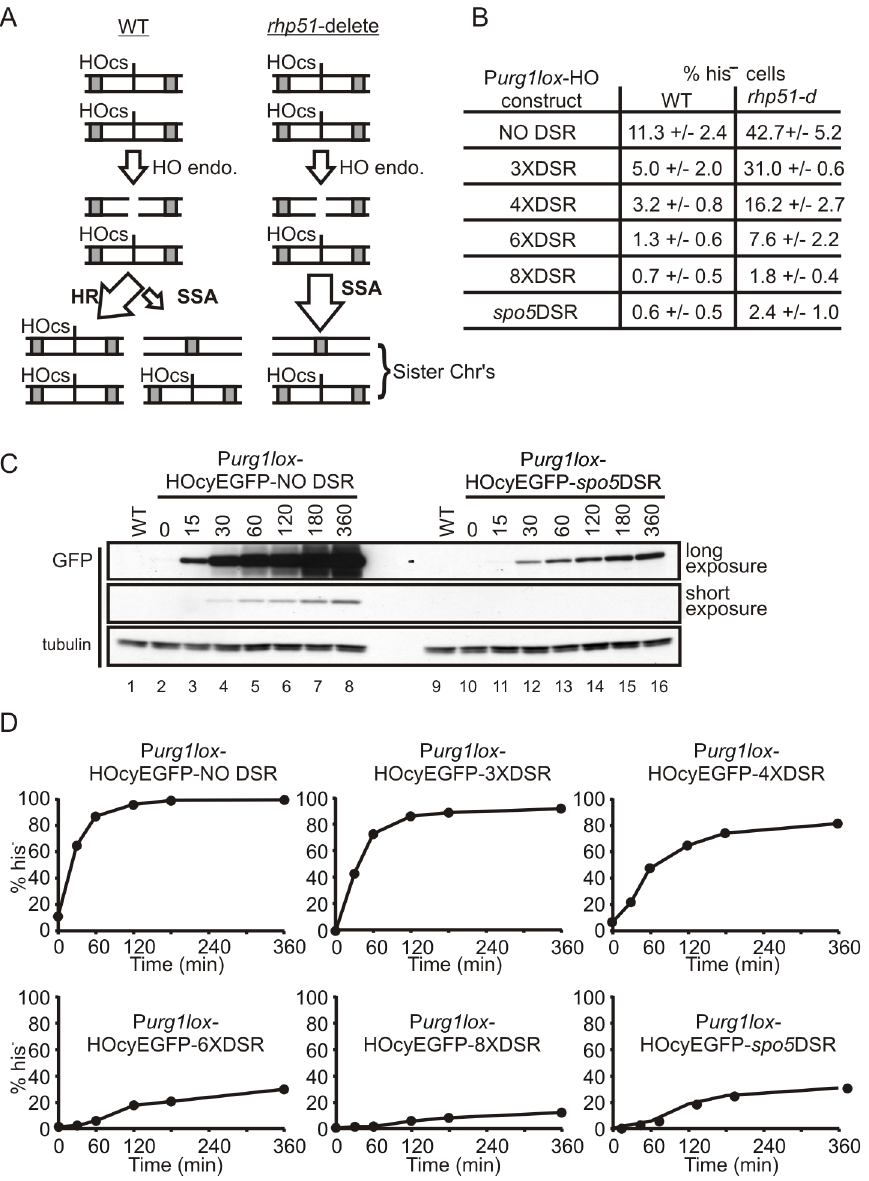
Figure 3. DSR activity reduces both induced and repressed P urg1lox protein levels. ( A ) Schematic illustration outlining the repair of a single HO-induced DSB in a G2 phase S. pombe cell. Repair in a normal (WT) cell can occur by either by homologous recombination (HR) or single strand annealing (SSA) (left panel) whereas repair in an HR deficient rhp51 -delete cell can only occur via SSA (right panel). Grey box = region of homology, HOcs = HO endonuclease cut site. ( B ). Steady-state rate of his3 + marker loss in WT HR proficient cells compared to HR deficient rhp51 -delete cells. The HO endonuclease ORF tagged at the C-terminus with yEGFP was inserted by Cre-mediated cassette exchange into the urg1 locus in WT cells containing the HOcs-HIS construct to create AW741 (NO DSR), AW743 (3XDSR), AW745 (4XDSR), AW747 (6XDSR), AW749 (8XDSR) and AW751 ( spo5 DSR) and in rhp51 -delete cells to create AW734 (NO DSR), AW816 (3XDSR), AW818 (4XDSR), AW820 (6XDSR), AW822 (8XDSR) and AW739 ( spo5 DSR). Logarithmically growing cells cultured in EMM + L were plated onto EMM + LH plates and grown at 30 u C. Colonies were replica plated onto EMM + L plates and the percentage of histidine auxotrophic (his 2 ) cells calculated. The assay was repeated at least three times and the average numbers are presented as the mean + /– SD. ( C ) The kinetics of HO-cyEGFP protein accumulation is unaffected by DSR activity. Time-course showing accumulation of HO-cyEGFP protein levels following induction of P urg1lox . Logarithmically growing AW671 (NO DSR) and AW673 ( spo5 DSR) cells (see Table 1) were induced by the addition of uracil at 0.25mg/ml. HO-cyEGFP protein levels were examined by western blot analysis as described in Figure 2B. Samples taken at time points shown (mins). ( D ) DSR activity slows his3 + marker loss in the P urg1lox -HO/HOcs-HIS SSA assay. Strains AW741 (NO DSR), AW743 (3XDSR), AW745 (4XDSR), AW747 (6XDSR), AW749 (8XDSR) and AW751 ( spo5 DSR) were grown in EMM + L to mid-log phase and uracil added at 0.25 mg/ml to induce P urg1lox . Cells were plated onto EMM + LH plates and grown at 30 u C. Colonies were replica plated onto EMM + L plates and the percentage of histidine auxotrophic cells calculated. Samples taken at time-points shown (mins). The assay was repeated twice and numbers shown are the mean. X axis = percentage of histidine auxotrophic cells, Y-axis = time in minutes.